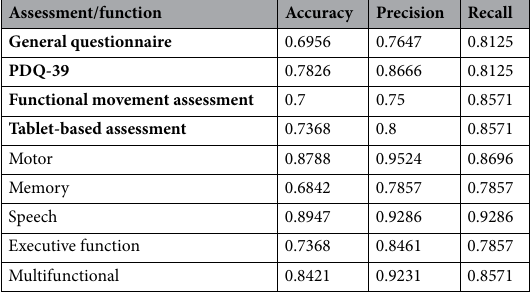
Table 3. Accuracy, precision, recall for classification of individuals with PD in early and advanced stages of PD for overall assessments and subfunctional neurocognitive areas.